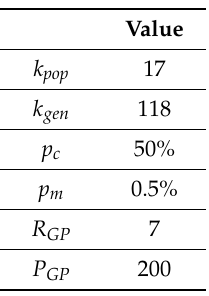
Figure 15. Averaged over 100 evolutions ( a ) Fitness and ( b ) cost function evolution according to the generation with k gen = 118, k pop = 17, p m = 0.5% ( IC s = 800 € m − 2 , EC = 0.17 € kWh − 1 , b an = b cath = 0.15 V dec − 1 ). Eventually, the evolution parameter are summarized in Table 8. Table 8. Optimum evolution parameters.